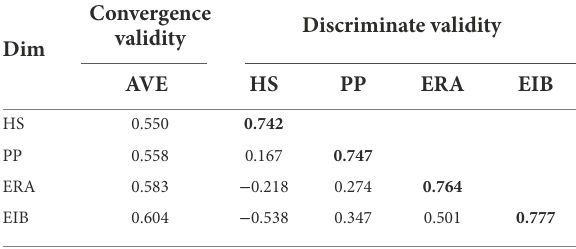
test whether the intercept and slope of the first level regression model existed. The correlation analysis model is shown below. In this model, both the hindrance stress and the proactive personality factors were group-centered. The results are shown in Table 3: H1, H2, and H3 were verified. Meanwhile, σ 2 was 0.157, with a decrease of 0.078; this indicates that, when the hindrance stress, proactive personality, and their interaction are added to the first level, the proportion of variance within